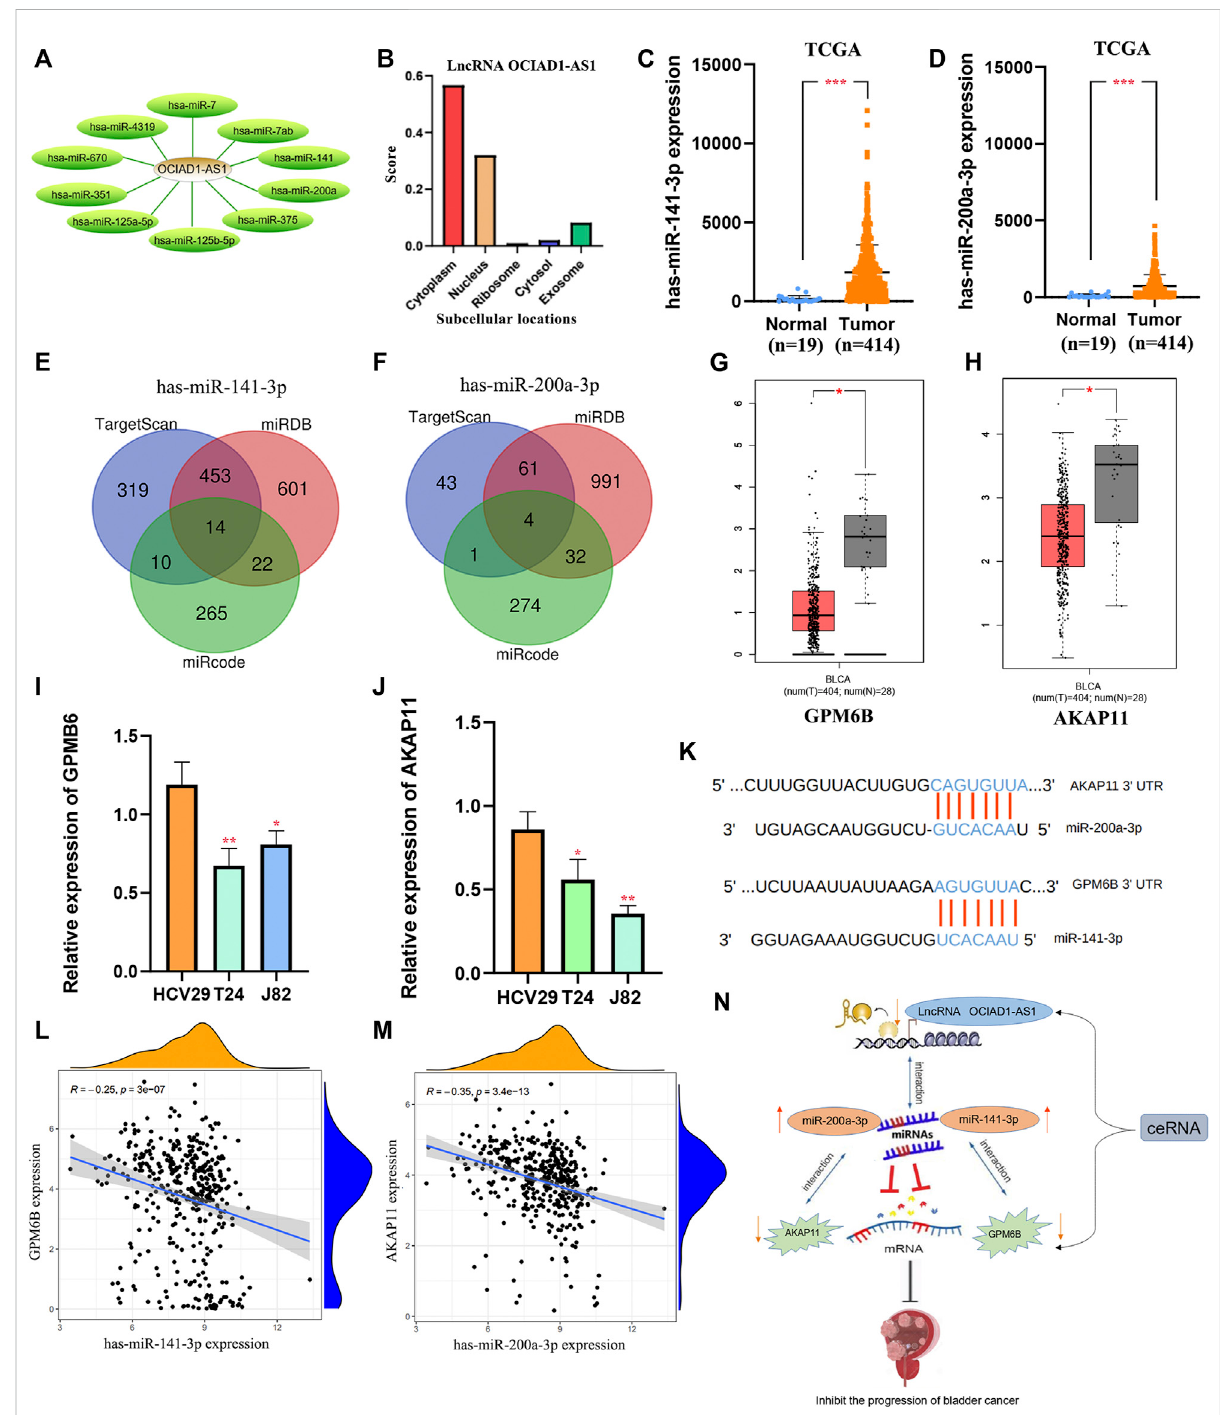
FIGURE 11 Construction of regulatory axes. (A) lncRNA OCIAD1-AS1 bound 10 miRNAs. (B) lncRNA OCIAD1-AS1 was concentrated in the cytoplasm than other subcells. (C,D) : Compared to normal tissues, miR-141-3p and miR-200a-3p were low-expressed in BC tissues. (E,F) : 14 mRNAs and 4 mRNAs were identi fi ed as downstream targets in miR-141-3p and miR-200a-3p, respectively, from miRDB, Mircode, and TargetScan database. (G,H) : GPM6B and AKAP11 were down-regulated in bladder cancer tissues compared to normal tissues by the GEPIA database. (I,J) : RT-qPCR results of GPM6B and AKAP11 in two human bladder cancer cell lines (J82 and T24) and a normal urinary tract cell line (HCV29). (K) The miR-141-3p and miR-200a-3p binding sites in BC. (L,M) : The correlation of GPM6B and AKAP11 with miR-141-3p and miR-200a-3p respectively in BC tissues. (N) : The ceRNAs of lncRNA OCIAD1-AS1/miR-141-3p/GPM6B and lncRNA OCIAD1-AS1/miR-200a-3p/AKAP11 regulatory axes. * p < 0.05, ** p < 0.01; *** p <